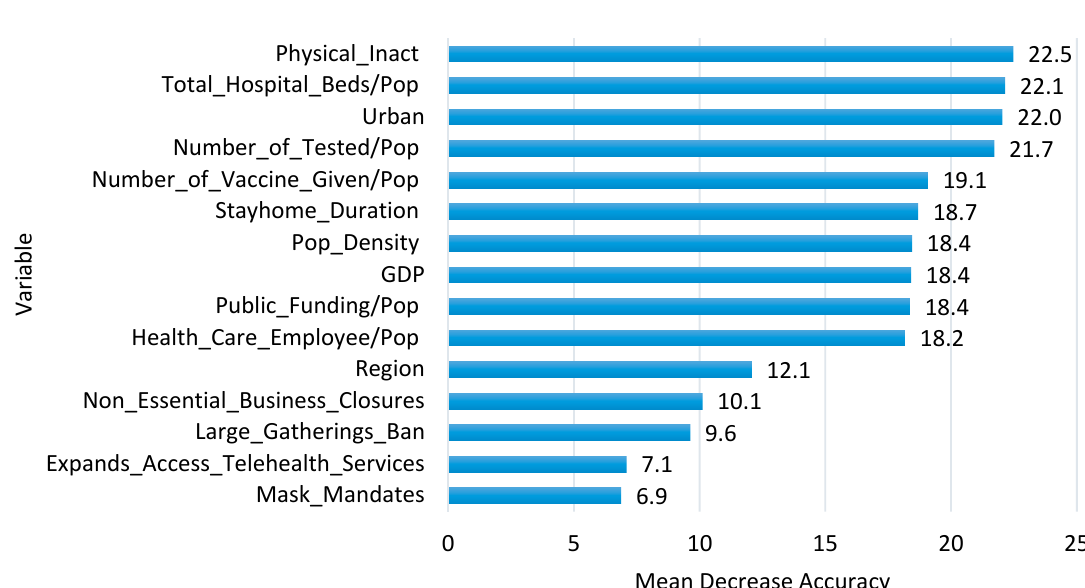
Figure 3. CART Results for States COVID-19 Responsive Performance.